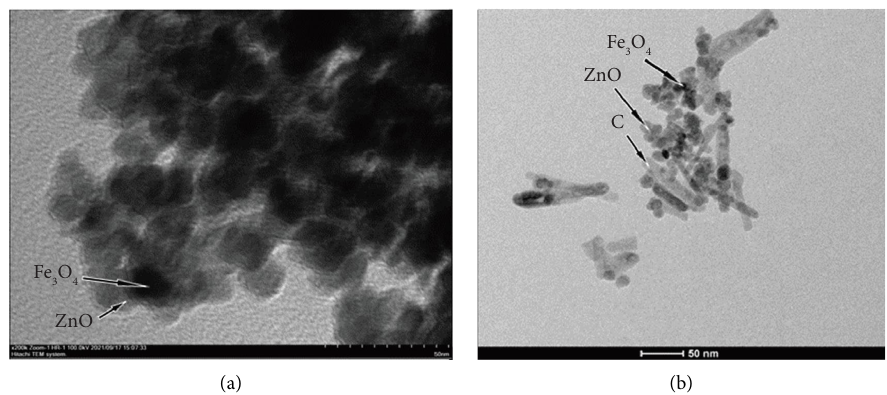
Figure 3: TEM image of (a) Fe 3 O 4 @ZnO and (b) Fe 3 O 4 @ZnO/C nanocomposites.